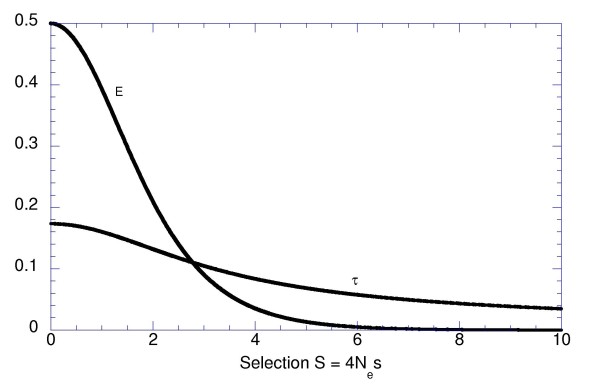
Asymptotic divergence E and half-approach period τ = ln 2/r in the case of two alleles, as functions of the selection coefficient.